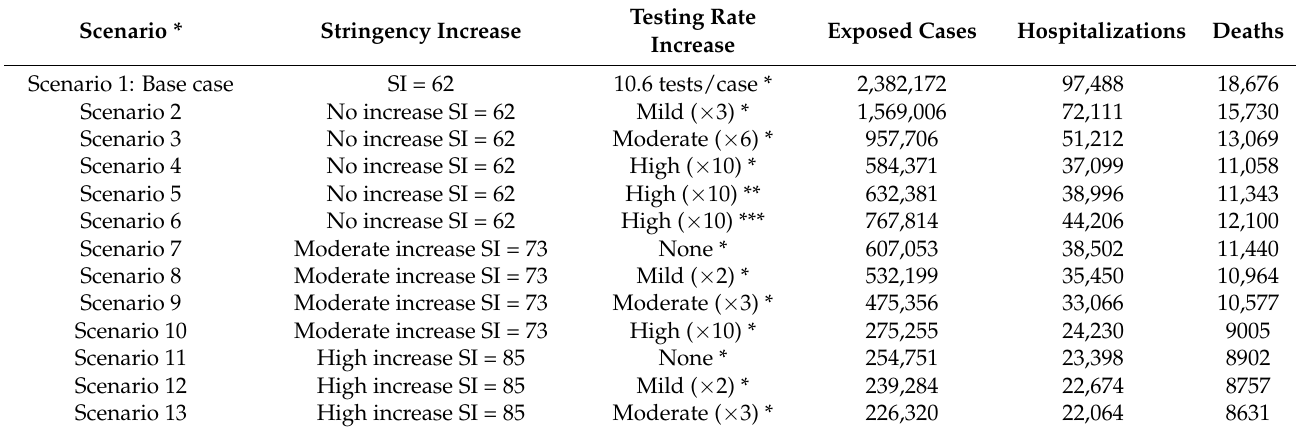
Table 1. Total number of new exposed cases, hospitalizations and deaths estimated by scenario.